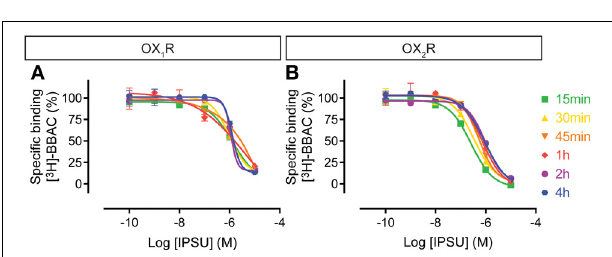
FIGURE 8 | Effect of time on IPSU competition for [ 3 H]-BBAC ((S)-N-([1,1 (cid:2) -biphenyl]-2-yl)-1-(2-((1-methyl-1H-benzo[d]imidazol-2- yl)thio)acetyl)pyrrolidine-2-carboxamide) binding to membranes from CHO cells expressing human (A) OX 1 R or (B) OX 2 R. Data is representative of triplicate determinations and error bars indicate